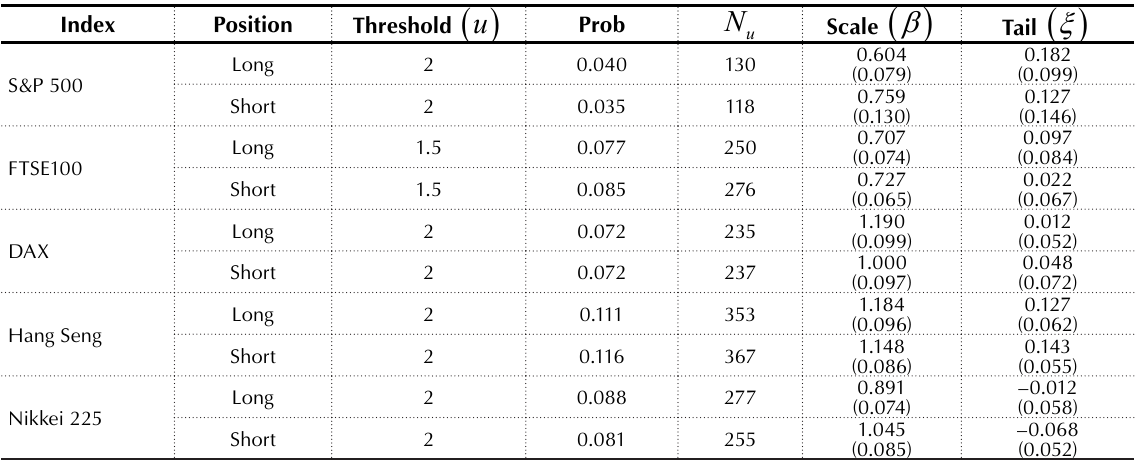
Table 1. Generalized Pareto distribution (GDP) parameter estimates for futures